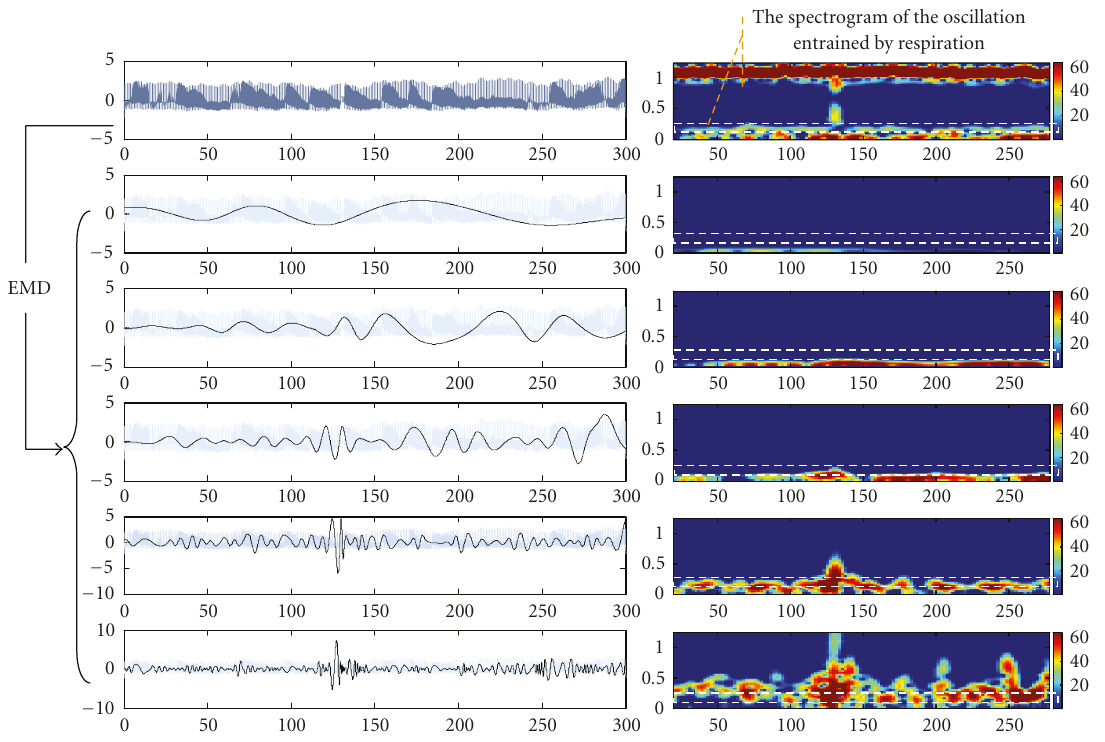
Figure 1: (Left panel) A raw BP signal and its decomposed empirical modes (i.e., c 5 – c 9 components from bottom to top) obtained by the EMD method. (Right panel) The corresponding short-time Fourier transform (STFT) spectrograms of the signals in left panel. The spectrogram was obtained using Gaussian sliding window with time duration of 40 seconds, shifted 2 seconds between successive evaluations and then plotted using color